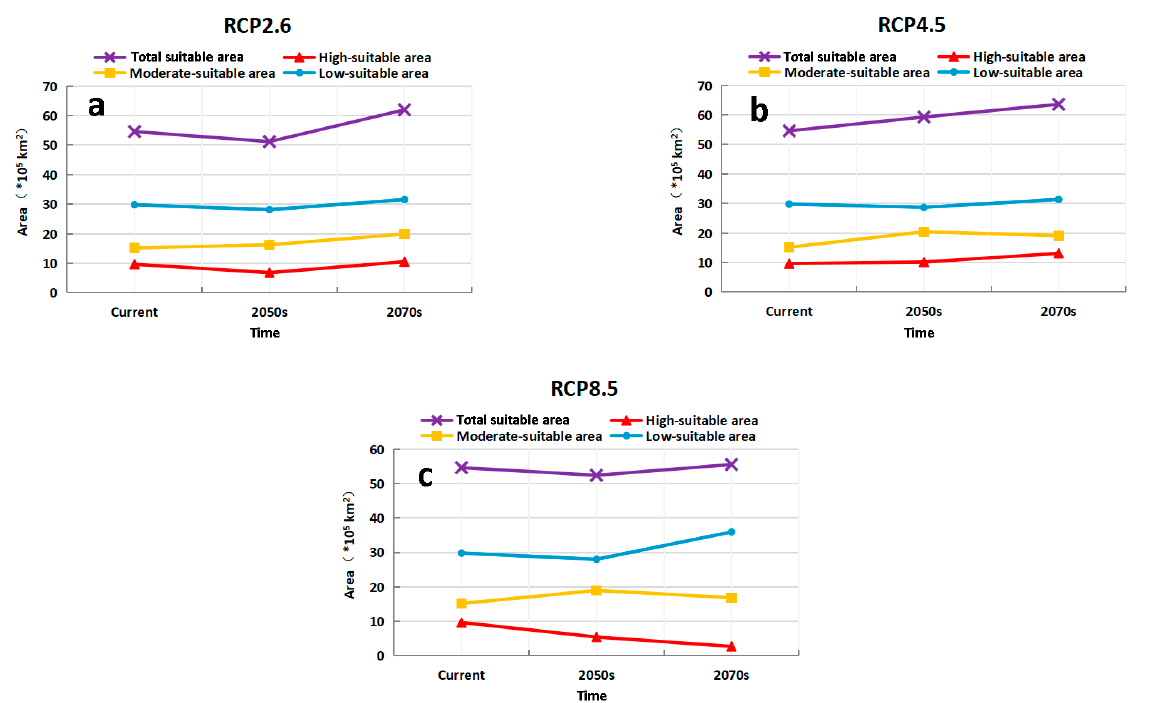
Figure 9. Predicted trend of the grades of habitat suitability for M. destructor in China under different future climate scenarios. (a) area in different periods under RCP2.6 (the minimum gas emission scenarios), (b) area in different periods under RCP4.5 (the medium gas emission scenarios), (c) area in different periods under RCP8.5 (the maximum gas emission scenarios).